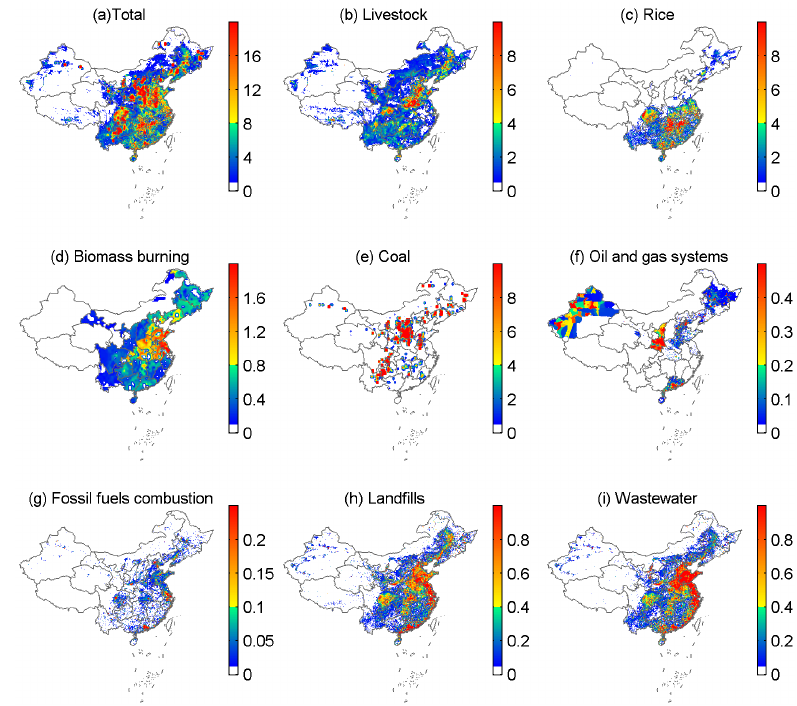
Figure 3. Spatial distribution of (a) total anthropogenic CH 4 emissions and (b–i) CH 4 emissions from different source sectors in mainland China in 2010. The unit of the color bar is gCH 4 m − 2 yr − 1 . Note that subplots have a different color